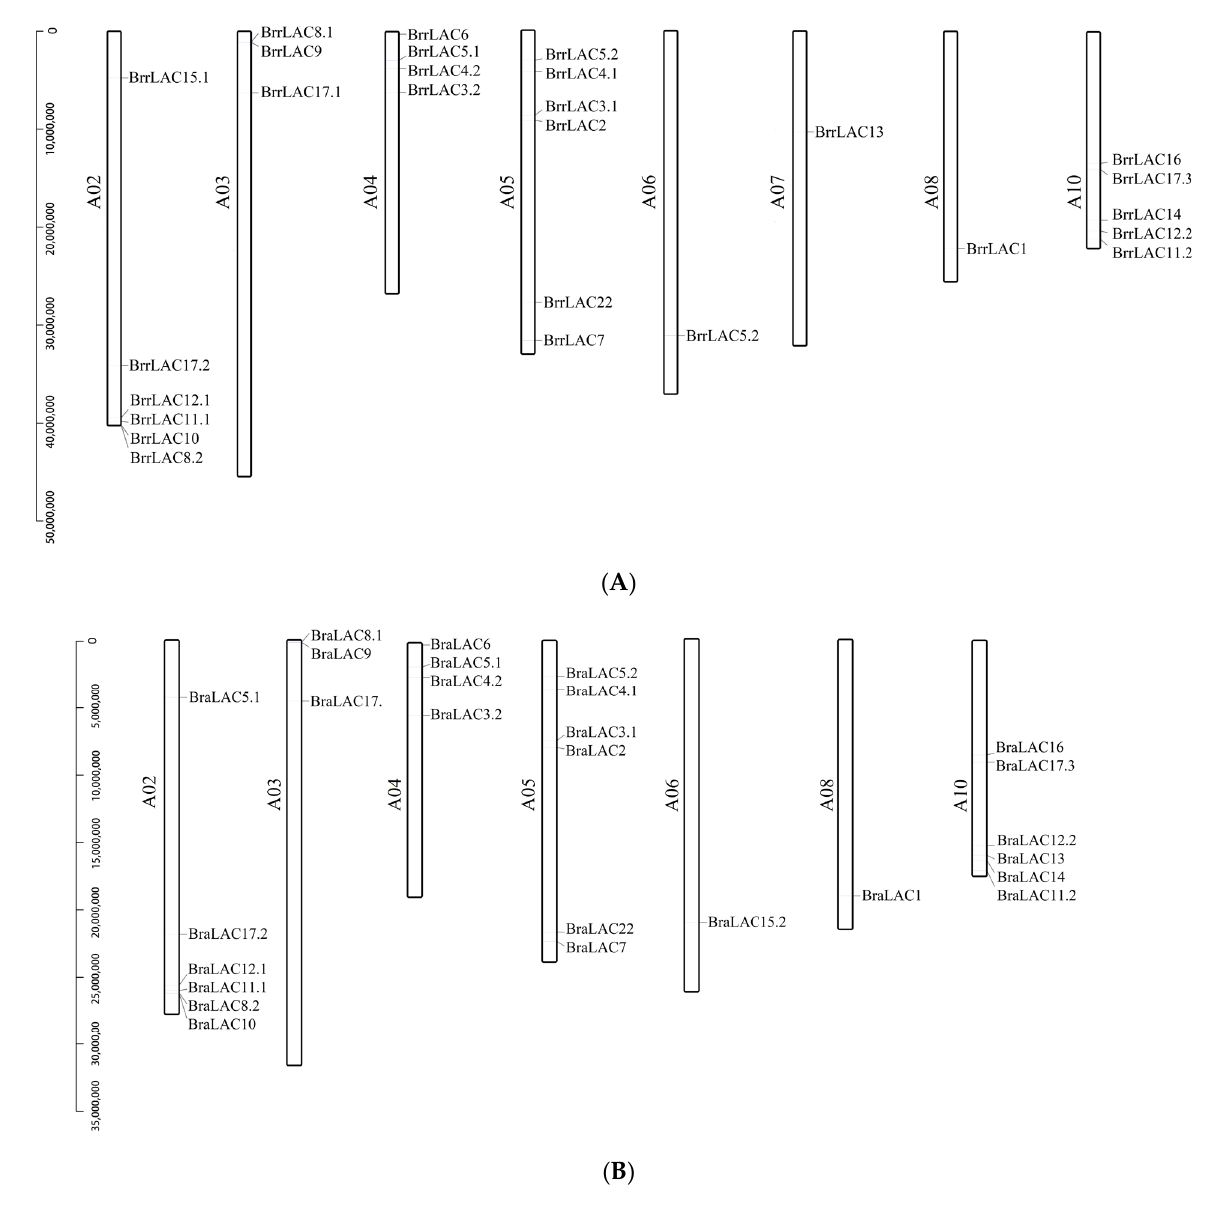
Figure 4. Chromosomal locations of LAC genes for turnip ( A ) and Chinese cabbage ( B ). The chromo- some numbers are shown on the left side of each chromosome. Locations of LAC s on chromosomes are indicated according to the location of the genes and length of chromosomes. Chromosomal distances are given in